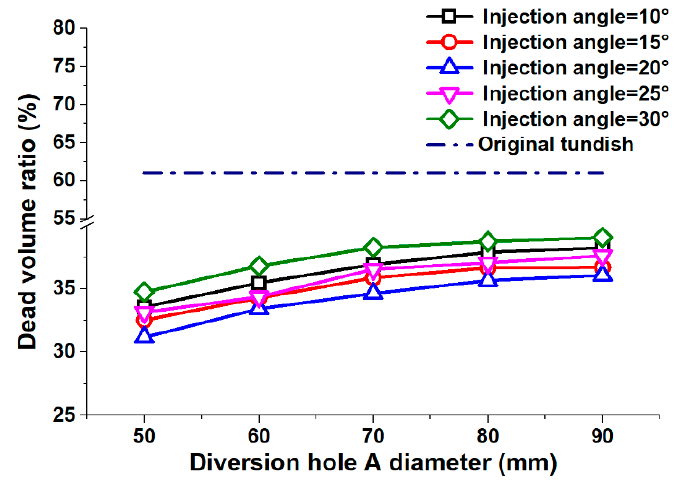
Figure 7. Dead volume ratio distribution.